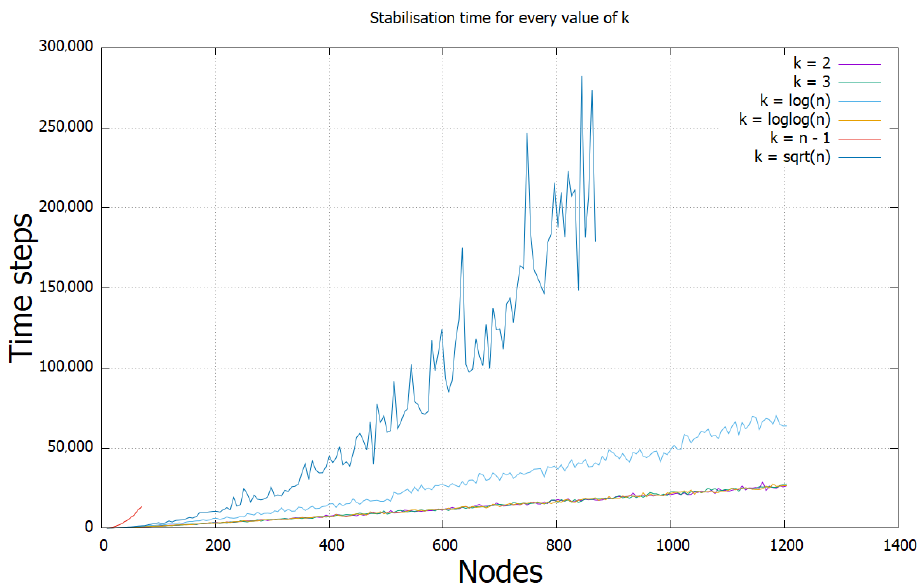
Figure 2. The effect of k on the running time of the